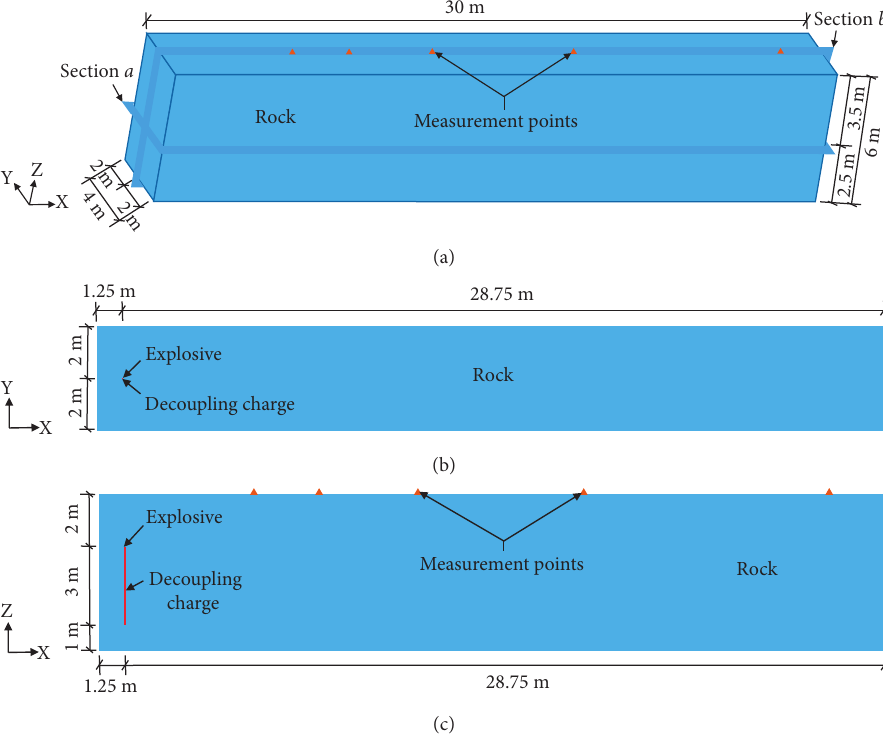
Figure 2: Single-hole analysis model considering middle and far zone vibration. (a) The entire model. (b) Section (a). (c) Section